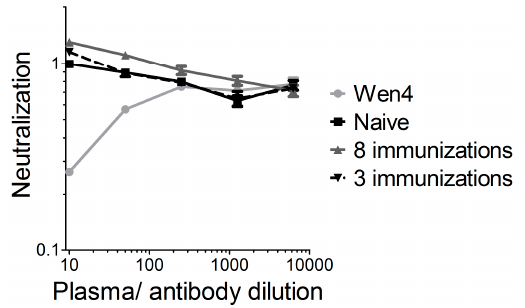
Figure 5. No vector-neutralizing antibodies were induced in mice after repeated VSV-GP injection. C57BL6 mice were immunized either three times (weeks 0, 8, and 16), and plasma was collected 23 weeks after the first immunization, or mice were immunized eight times within 40 weeks (weeks 0, 2, 4, 6, 8, 10, 14, and 40) and plasma was collected 42 weeks after the first immunization. Plasma pools from four vaccinated animals were pre-incubated with the replication incompetent VSV* Δ G-GP virus and subsequently BHK-21 were infected. As a negative control, plasma from a naïve mouse was analyzed. As a positive control, the lymphocytic choriomeningitis virus (LCMV)-neutralizing mouse monoclonal antibody Wen4 was used. The 1:10 dilution from the naïve mouse was set to 1. The graph shows the mean ± SEM of triplicate samples.